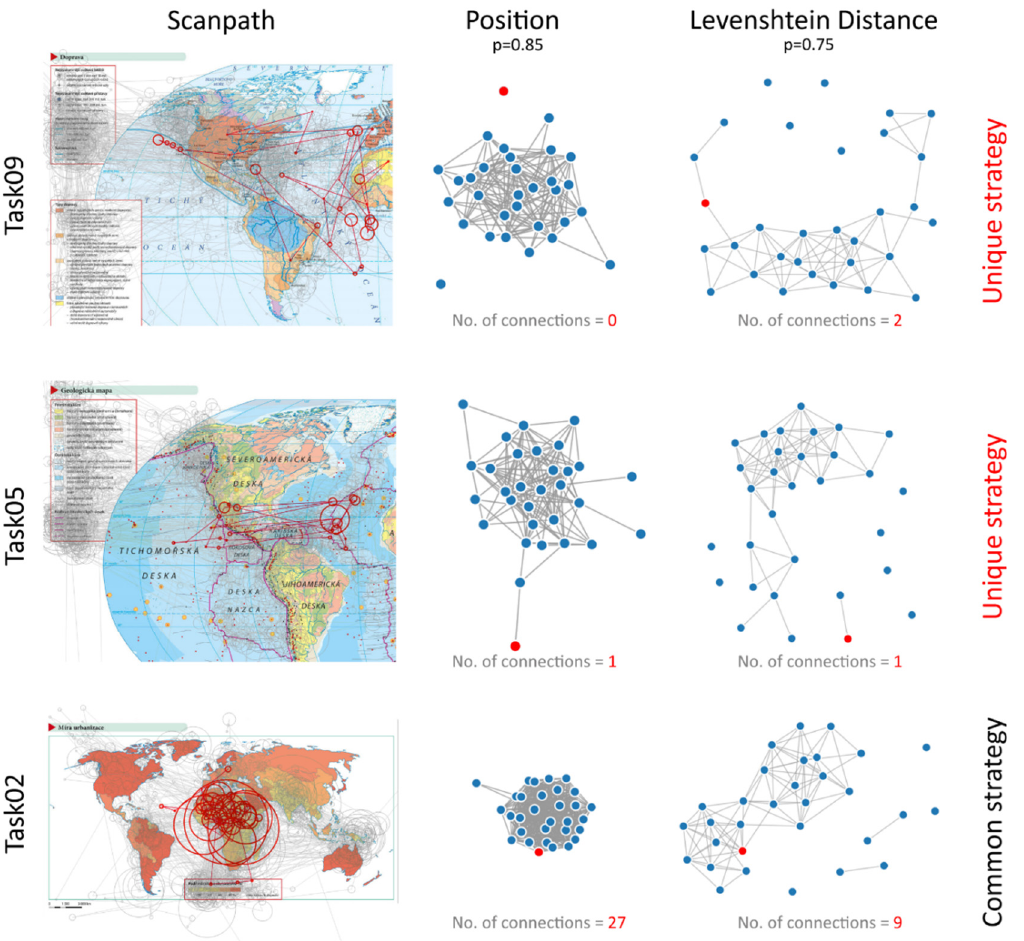
Figure 13. Comparison of students’ and teacher’s map-reading strategies. The left column indicates the scanpaths, the middle column shows the ScanGraph visualization of position measurement, and the right column depicts the results of Levenshtein distance (also visualized using ScanGraph). The teacher is in red.